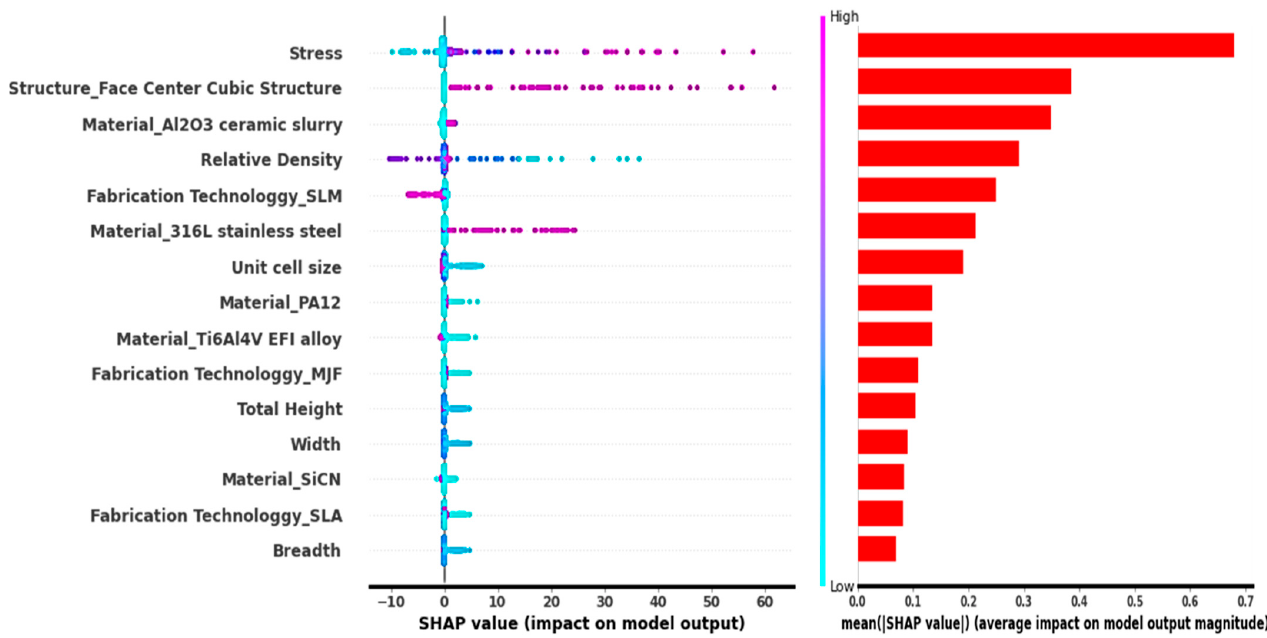
Figure 13. Summary plots to interpret the predictions of the DL model.